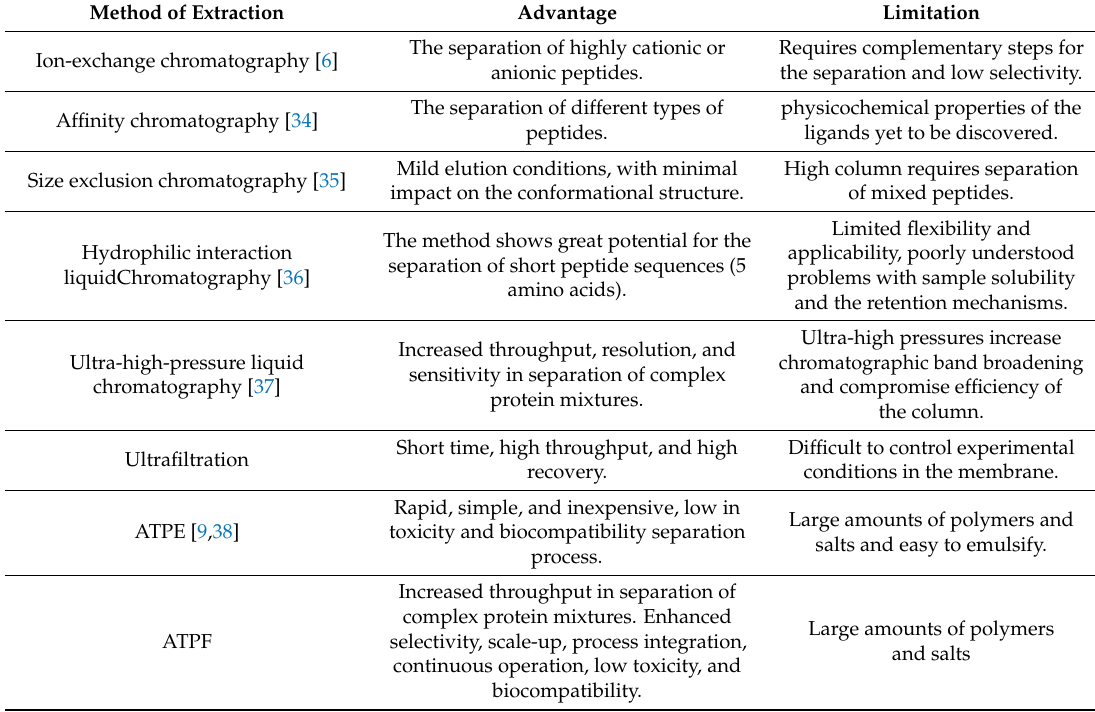
Table 4. Comparison of ATPE, ATPF and other methods of extraction. Method of